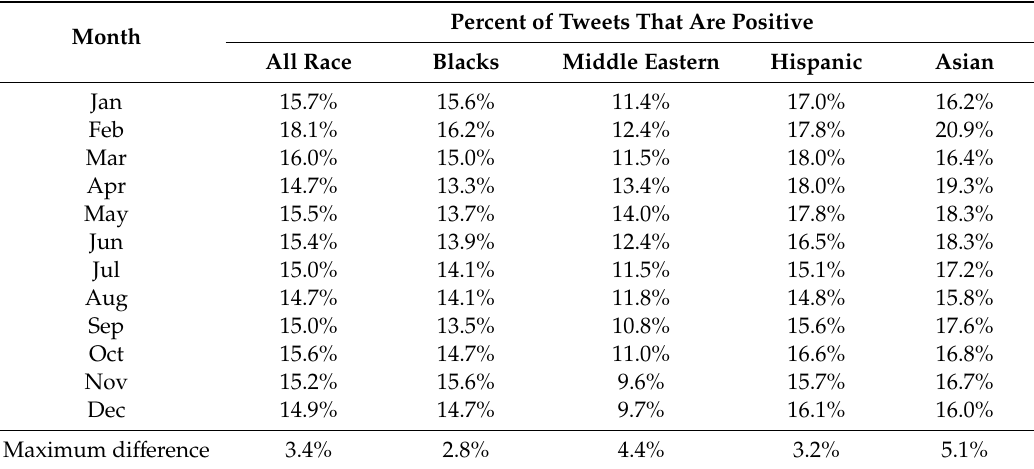
Table 1. Twitter-derived sentiment by month of year,